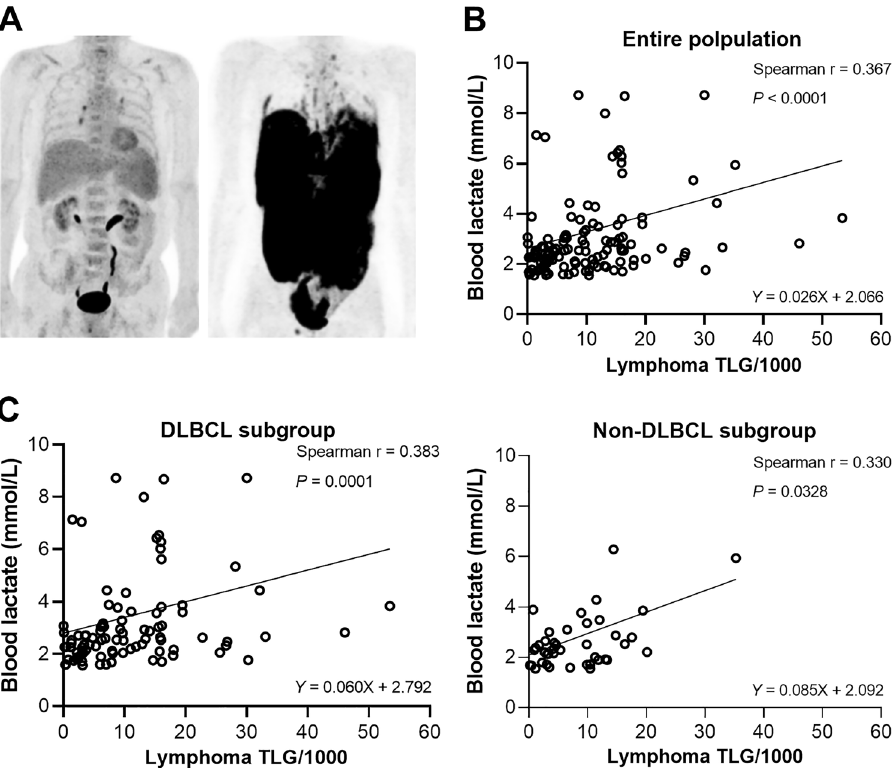
Figure 2. Blood lactate level is correlated with total lesion glycolysis (TLG) measured by FDG positron emission tomography (PET). ( a ) Representative maximum intensity projection FDG torso PET images of stage IV DLBCL patients. The 73-year-old male on the left had mildly elevated blood lactate to 1.6 mmol/L and a low TLG of 379, whereas the 41-year-old male on the right had a high blood lactate of 11.2 mmol/L and high TLG of 38,977. ( b ) Correlation in the entire population between blood lactate concentration and lymphoma TLG with linear regression fitting. ( c ) Correlation between blood lactate concentration and lymphoma TLG for DLBCL (left) and non-DLBCL